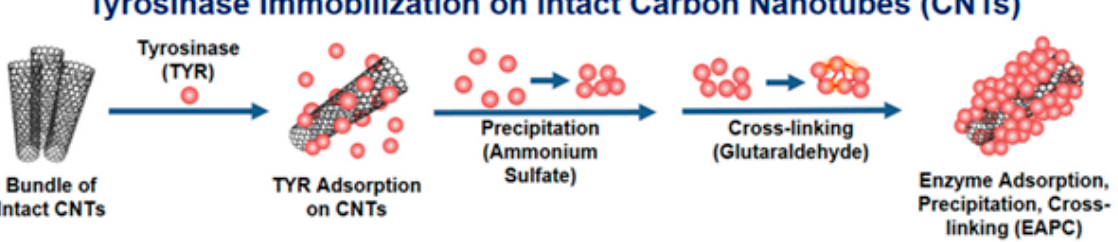
Figure 11. EAPC protocol, consisting of enzyme adsorption, precipitation and crosslinking. Reprinted with permission from [78]. Copyright 2023, copyright Elsevier.